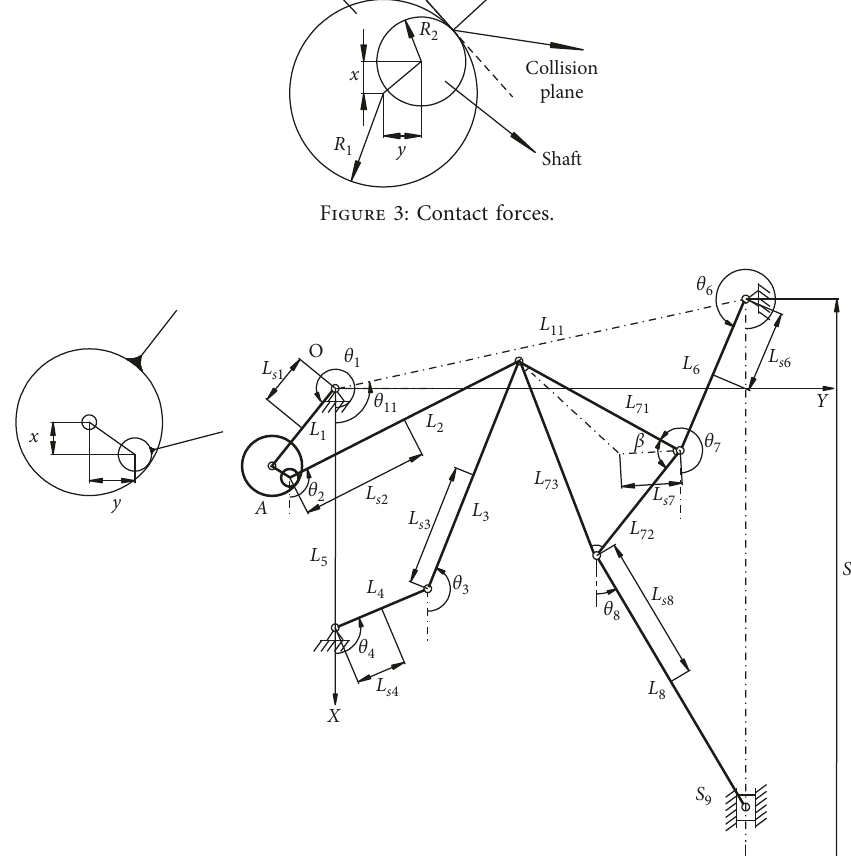
Figure 4: Coordinate system of the mechanism containing a revolute